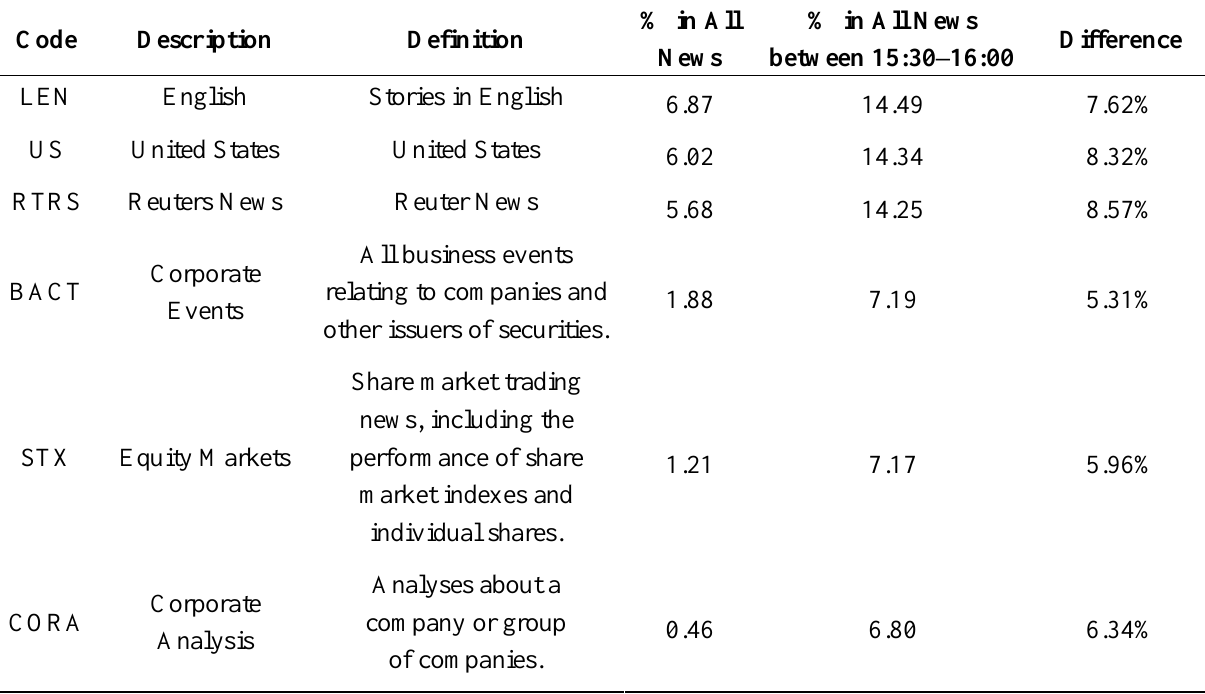
Table 3. Percentages of selected topic codes associated with news